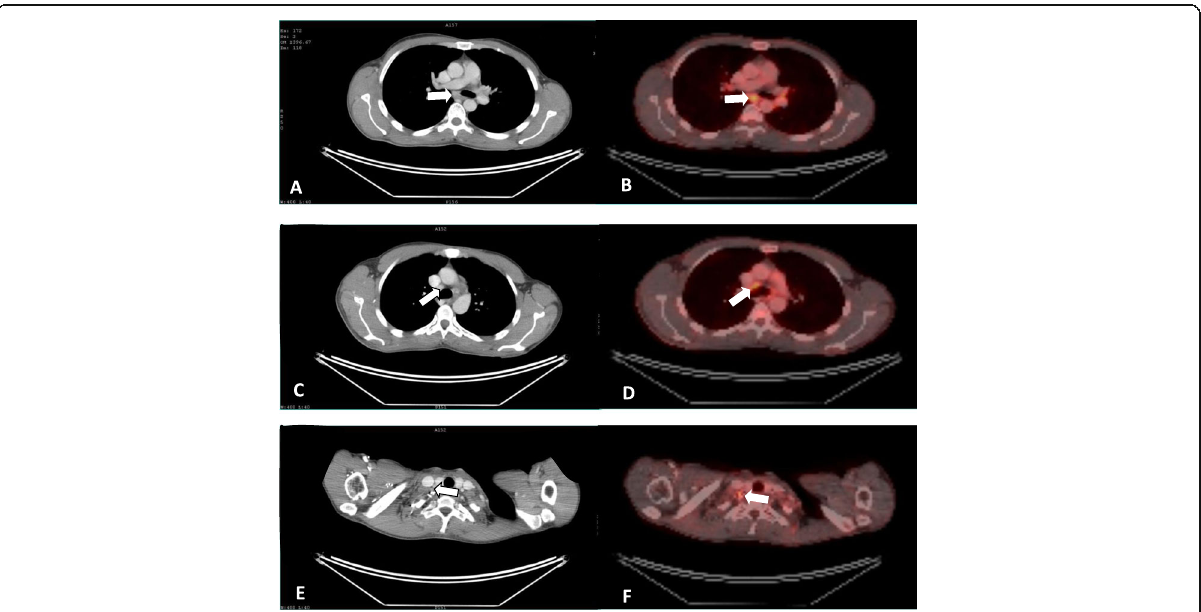
Fig. 4 Forty-two-year-old male patient, known case of Hodgkin lymphoma. Metabolically active pretracheal ( a – d ) and aortopulmonary LN groups, largest measures 1.4 × 0.8 cm with SUV max = 7.2 and multiple low metabolically active small retrocaval, paraaortic, and left common iliac ( e and f ) (likely inert lymph nodes) with SUV max 2.2, consistent with a score of 3 on the five-point scale